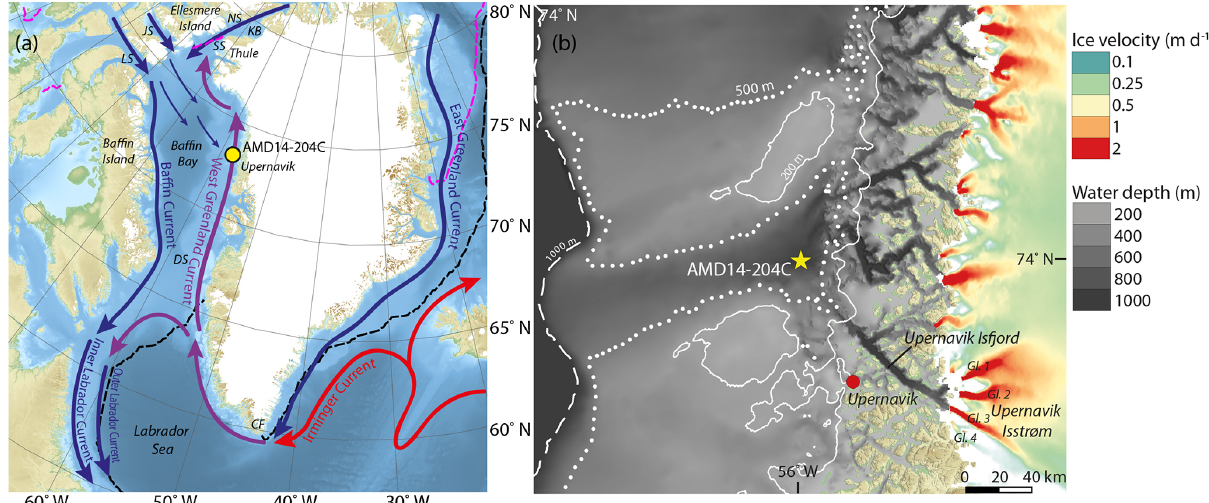
Figure 1. (a) Map showing the study site and the modern ocean surface circulation. Red, blue, and purple arrows represent warmer, colder, and mixed/intermediate water temperatures, respectively. The core AMD14-204C is marked with the yellow circle. The dashed pink and black lines mark the median sea-ice extent from 1981 to 2010 in September and March, respectively (NSIDC, 2019). Abbreviations: LS: Lancaster Sound; JS: Jones Sound; NS: Nares Strait; SS: Smith Sound; KB: Kane Basin; DS: Davis Strait; CP: Cape Farewell. (b) Close-up on the Upernavik Isstrøm area, showing the local bathymetry and ice stream velocities. The Upernavik Isstrøm is comprised of four glaciers. The ocean bathymetry and bed topography data are derived from GEBCO (Weatherall et al., 2015) and BedMachine v3 (Morlighem et al., 2017), and the ice stream velocity data are derived from Sentinel-1 SAR data acquired from 28 December 2017 to 28 February 2018 (Nagler et al., 2015). Abbreviation: Gl.: